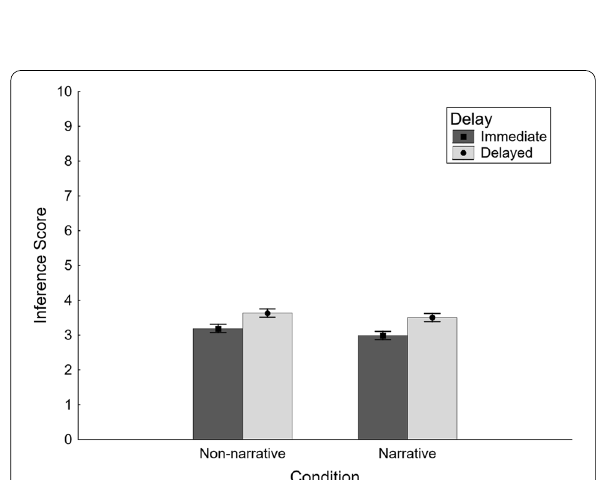
Fig. 2 Mean myth-belief-change scores across conditions in Experiment 2; theoretically-possible range was bars indicate within-subjects standard error of the mean (Morey 2008)